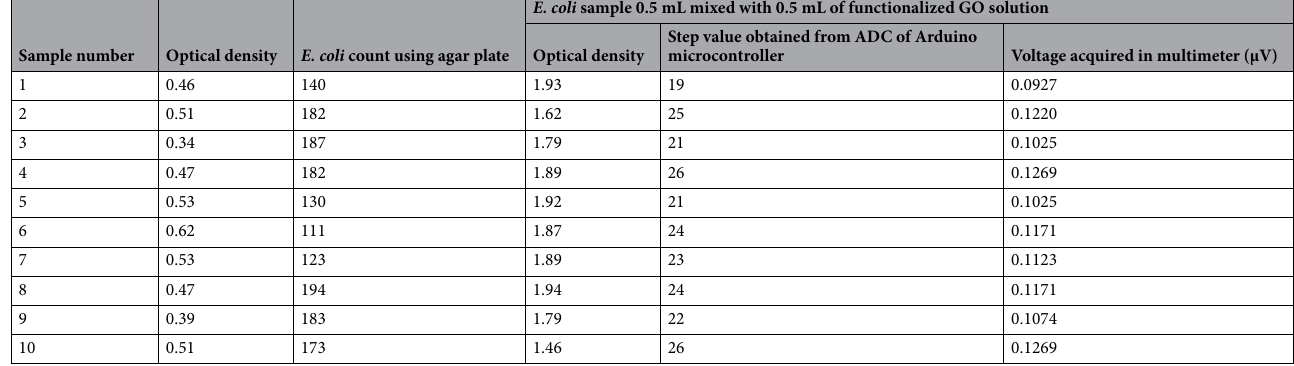
Table 4. Experimental data for a real water sample and using developed nanosensor—laboratory